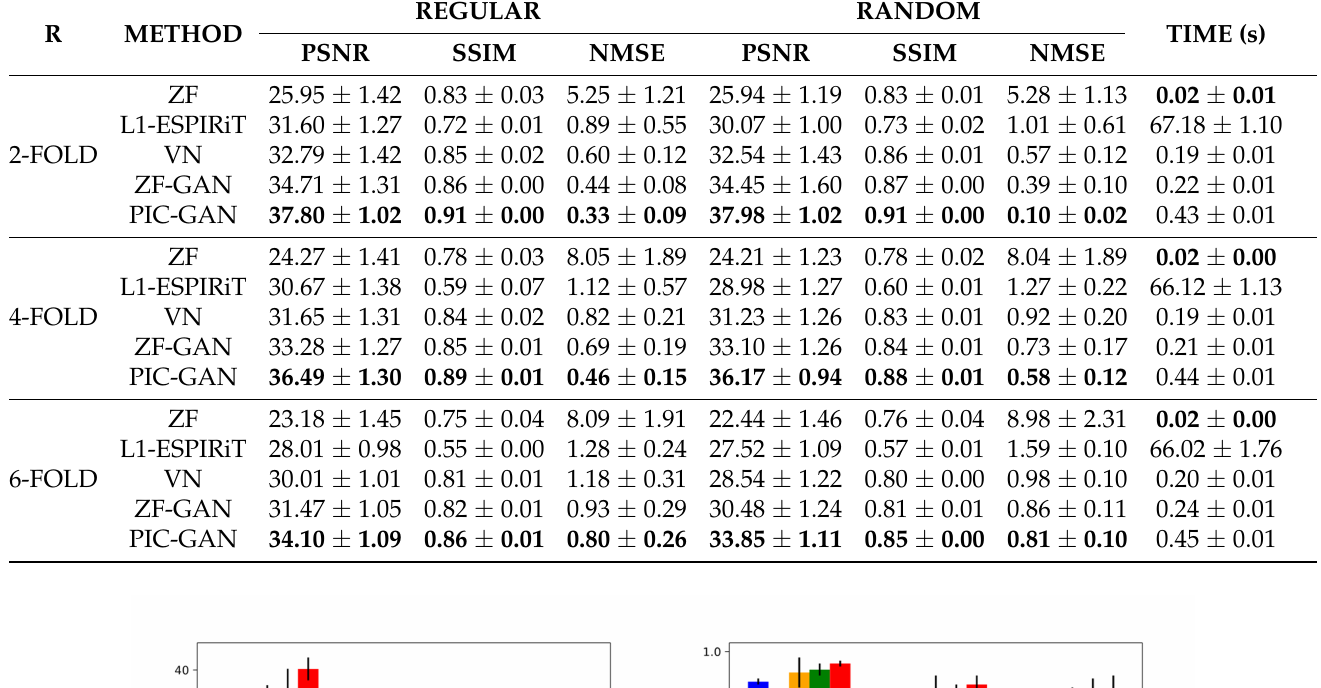
Table 2. Performance comparisons (NMSE × 10 − 5 , SSIM, PSNR and Average Reconstruction Time(s)) on knee MRI data with different acceleration factors. The bold numbers highlight the best results. The PIC-GAN outperformed the competing algorithms with significantly higher PSNR, SSIM and lower NMSE values ( p < 0.05).